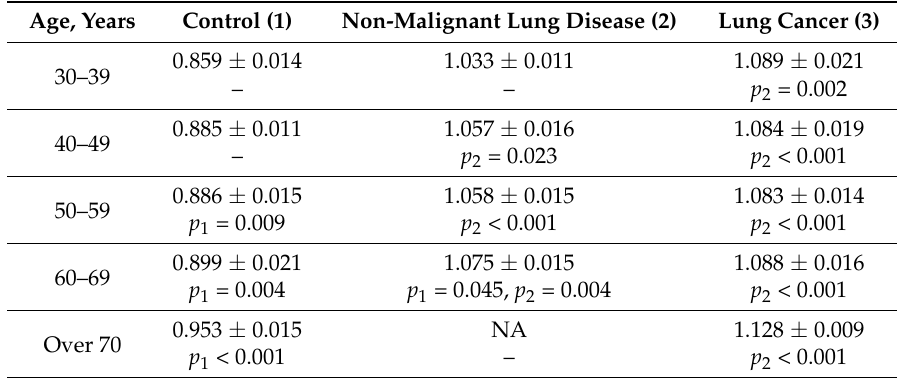
Table 3. Levels of triene conjugates in saliva of patients with lung cancer, non-malignant lung diseases and of apparently healthy patients